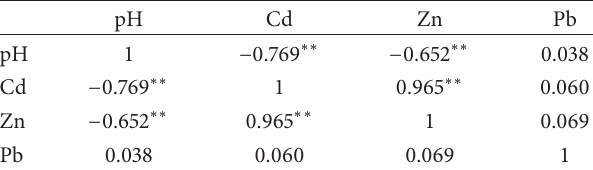
Table 5: Pearson’s correlation coefficients 𝑟 between Cd, Zn, Pb, and pH in leachates of control column ( 𝑛 = 30